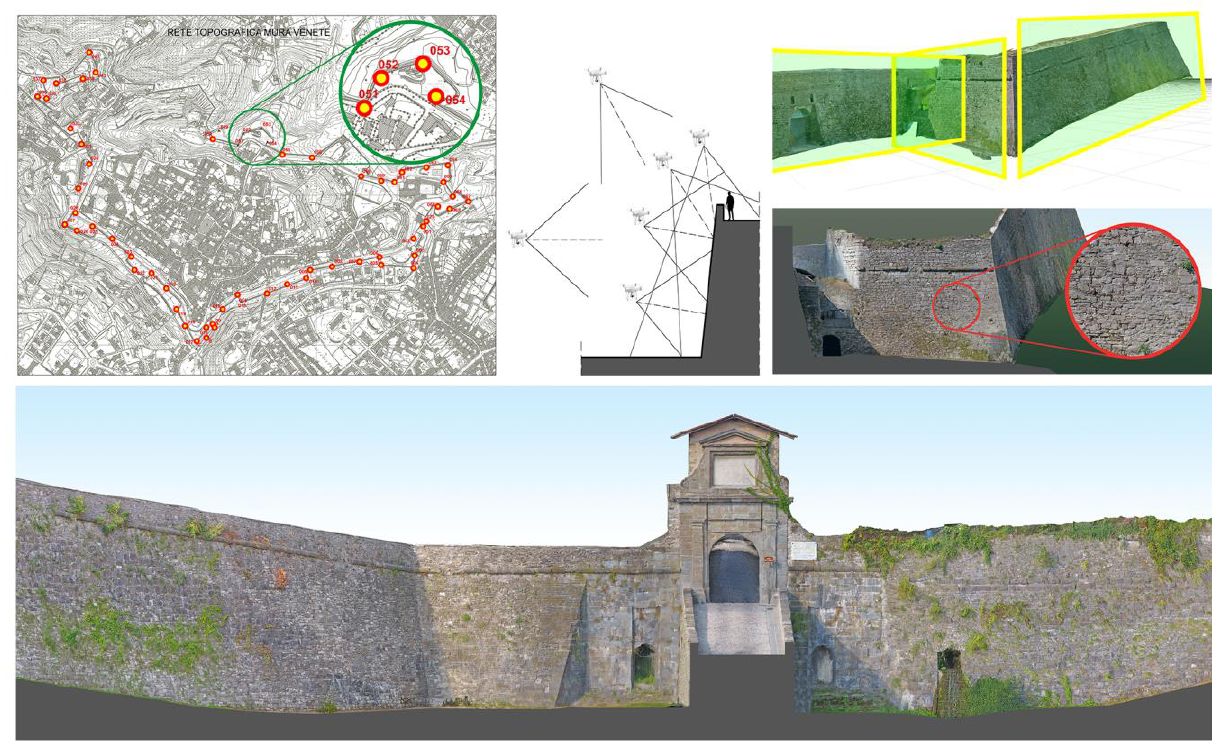
Figure 2. The phases of the photogrammetric acquisition and creation of the point cloud model: definition of the reference point network, UAV flight project and creation of the 3D model. On the bottom, ortographic projection of the walls near St. Lorenzo